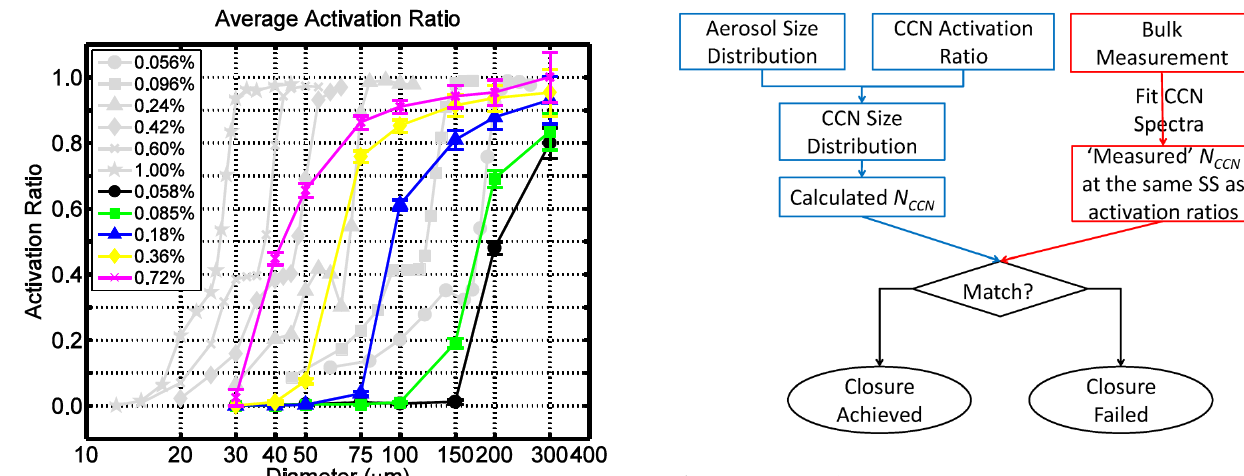
Figure 8 the Flowchart for CCN Closure between Bulk and Size-resolved Measurement 2 Fig. 8. Flowchart for CCN closure between bulk and size-resolved 3